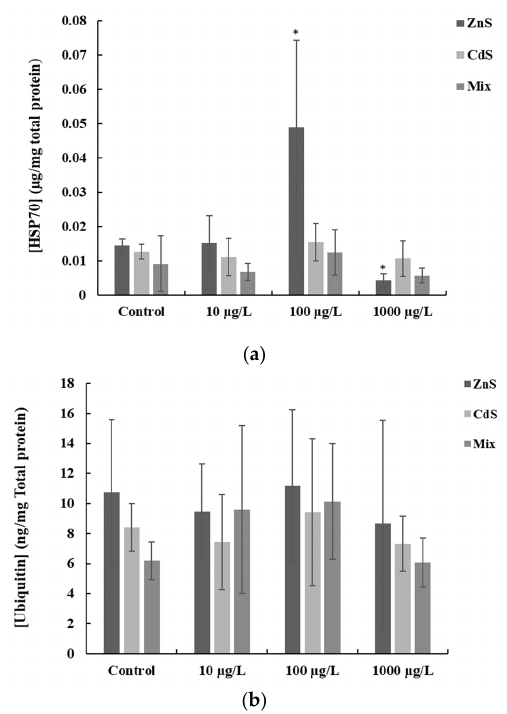
Figure 3. ( a ) HSP70 and ( b ) total ubiquitin (mean ± SD) in zebrafish exposed to different concentrations of QDs, alone and combined (Mix). Asterisk means significant differences ( p < 0.05) from the respective controls.